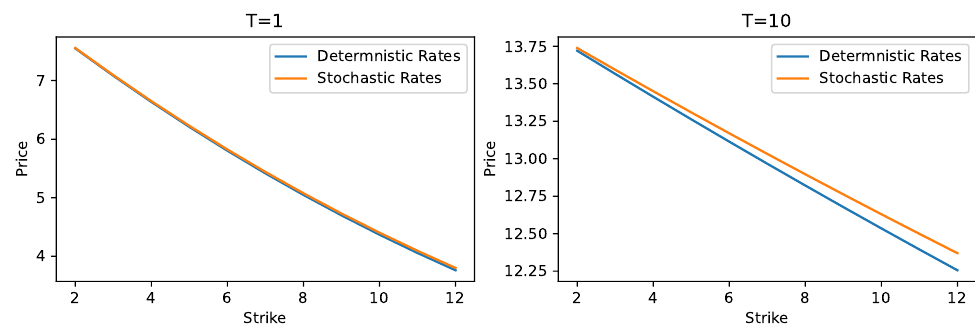
= 0.75, and ρ x = 0.6. 2 , r 1 , r